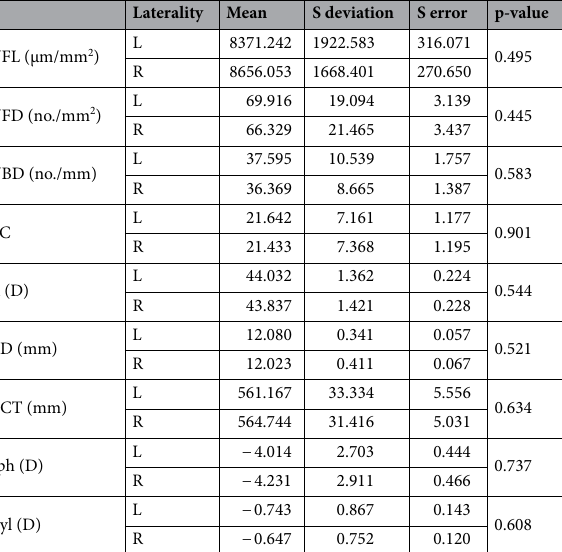
Table 2. Descriptive statistics for eyes’ laterality ( L left; R right) and test t p-value*. *NFL nerve fiber length (µm/mm 2 ), NFD nerve fiber density (no./mm 2 ), NBD nerve beadings density (no./mm), TC tortuosity coefficient, K corneal curvature ( D diopters), CD corneal diameter (mm), CCT corneal thickness (µm), Sph sphere ( D diopters), Cyl cylinder ( D